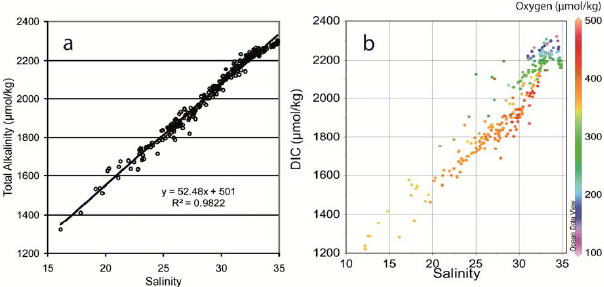
Fig. 6. Total alkalinity (a) and total dissolved inorganic carbon (b) versus salinity, where the latter is colored by the oxygen concentration.